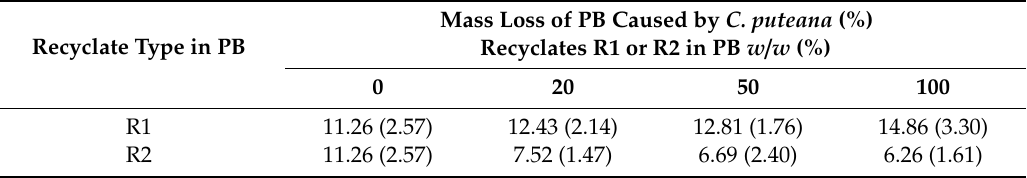
Table 5. Biological resistance of PBs containing recyclates R1 or R2—valued on the basis of mass losses ( Δ m) caused by the brown-rot fungus Coniophora puteana.